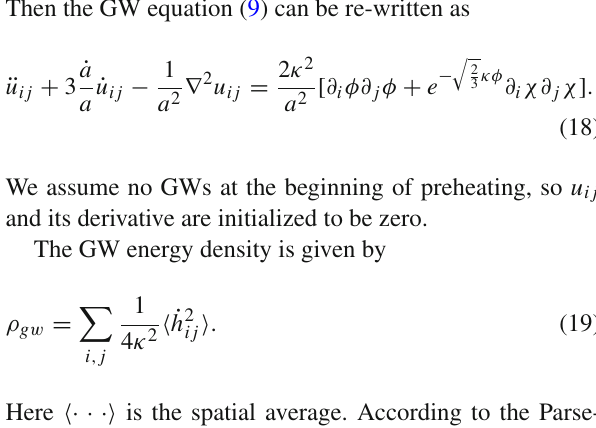
Fig. 1 The evolutions of the spectra of scalar fields as a function of k / H i with time t . The spectra from bottom to up are plotted with the time interval (cid:14) t = 0 . 1875 H − 1 . Bold lines show the final i